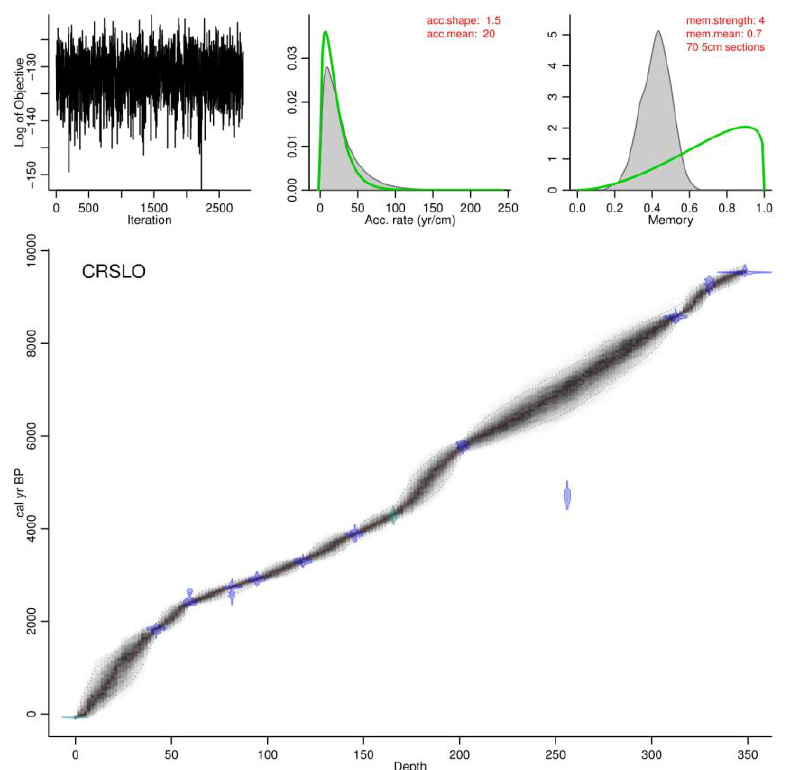
Figure A3h. Age-depth model produced in BACON for